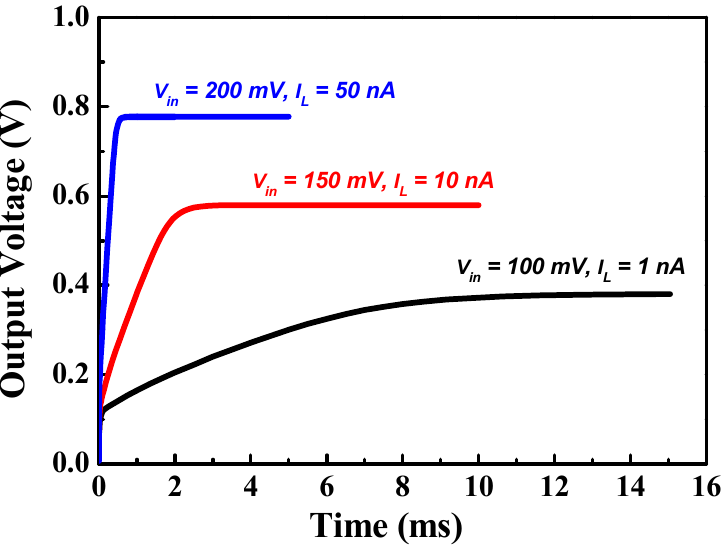
Figure 9. Transient output voltage of the proposed charge pump under various input voltage and load current conditions.